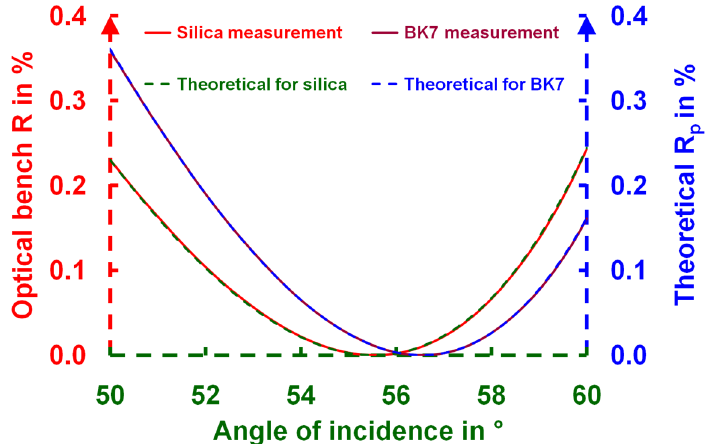
Figure 10. Measurements and simulations of a silica substrate and a BK7 substrate in p-polarization. Table 1. Summary of different results from Figure 8 and the calculated value of the coefficient K λ